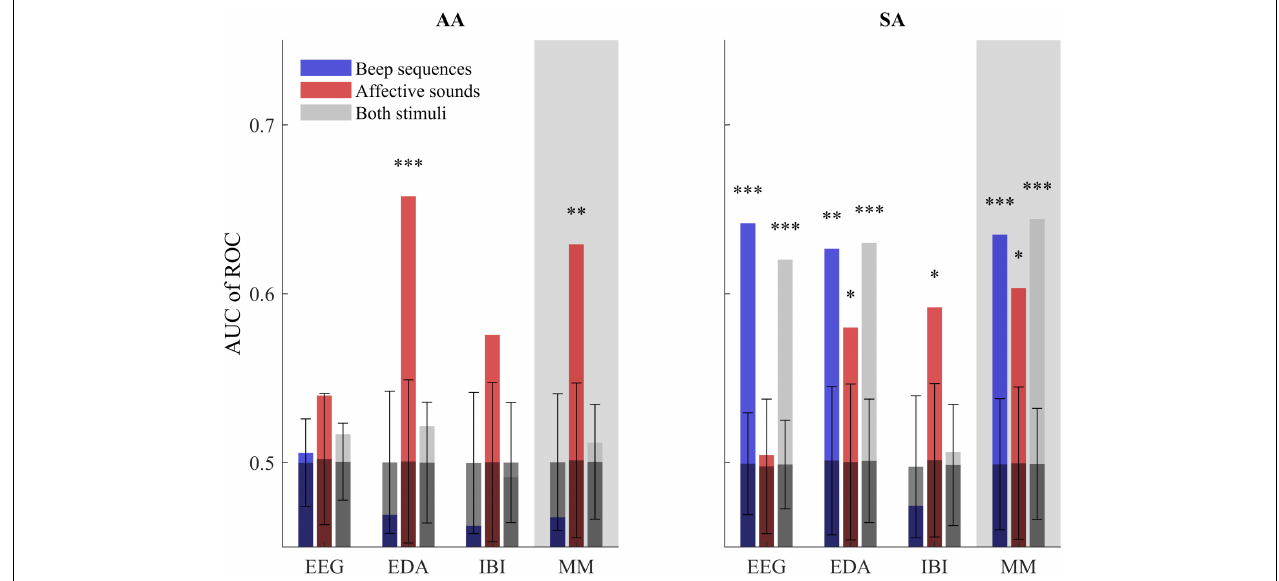
FIGURE 2 | AUC of ROC metric of stimulus detection performance using PS in EEG, EDA, IBI and a multi-modal combination of the three (MM). Performance is shown for the AA and SA groups, when considering only beep blocks or emotional sounds as true positives and when considering both types of stimuli as true positives. In addition, the mean and standard deviation chance level detection performance based on 1,000 renditions with randomized stimulus timing is shown with test results comparing detection performance to chance level ( ∗ p < 0 . 05 , ∗∗ p < 0 . 01, ∗∗∗ p < 0 . 001). Note that for the AA group, the emotional sounds but not the beeps are expected to draw (bottom-up) attention, i.e., for the AA group we expect high AUC for emotional sounds only. For the SA group, both beep sequences and emotional sounds are relevant and expected to draw